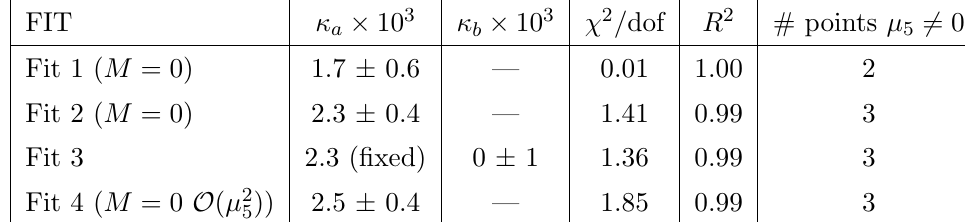
Table 1 . Numerical values of the parameters corresponding to the (cid:12)ts in (cid:12)gure 4. The last column indicates the number of lower (cid:22) 5 points